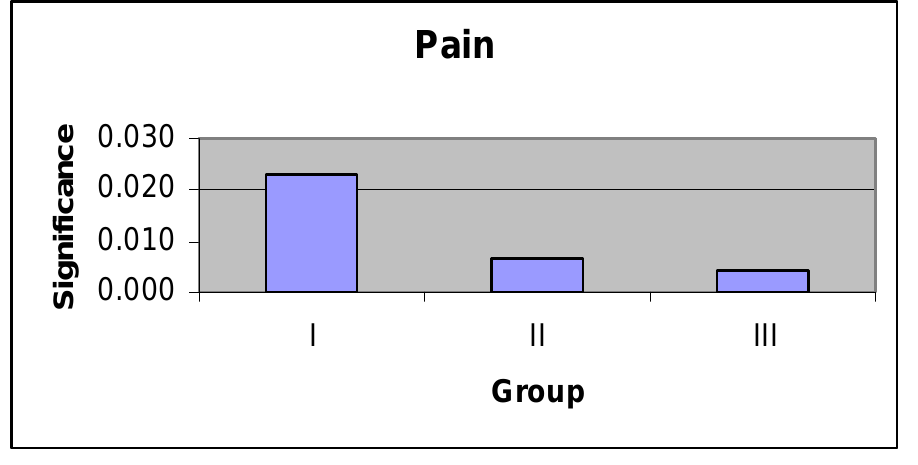
FIGURE 1. Pain changes.